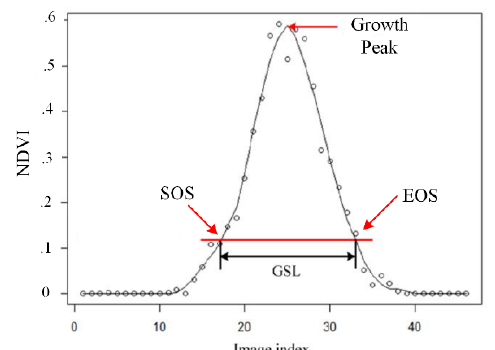
Figure 4. Vegetation growing curve and key phonological events.